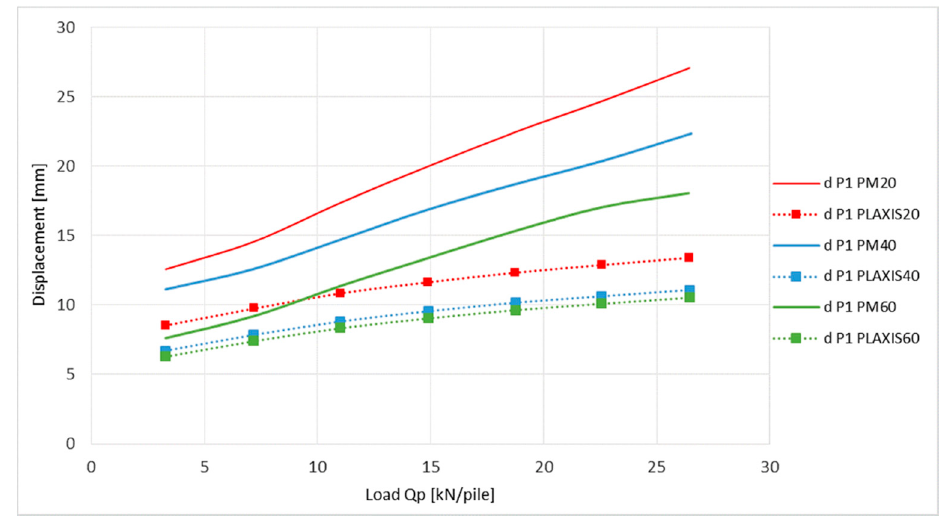
Figure 15. Comparison of vertical deflection of geogrid at place P1.